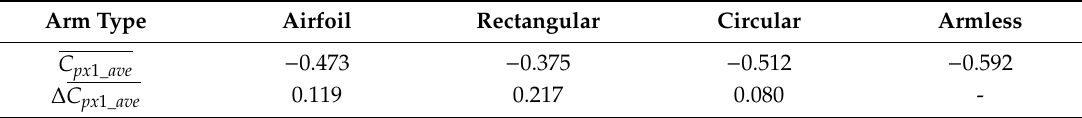
the half-blade span direction by Equation (10) are shown in Table 4. The bottom row of Table 4 shows the pressure-based tangential force coefficients ( Δ _ ) corresponding to the increase in the resistance of each blade, which were obtained from the difference between each averaged force the existence of the rectangular arms is 1.82 times as large as that of the airfoil arms; the case of the circular arms is 0.67 times as large as the case of the airfoil arms. Table 4. Middle row shows the pressure-based force coefficients averaged along the half-blade span direction. The values in the bottom row are pressure-based tangential force coefficients obtained from the difference between each force coefficient and that of armless rotor.